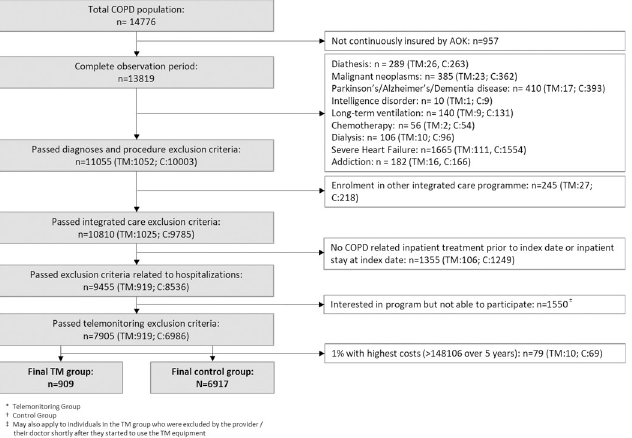
Fig 1. Selection criteria. TM = telemonitoring group, C = control group, ± may also apply to individuals in the telemonitoring group who were excluded by the provider or their physician shortly after telemonitoring started.